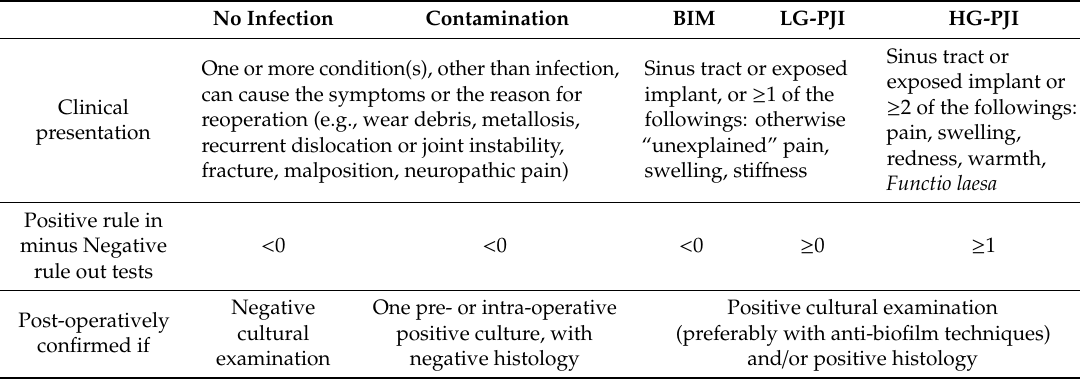
Table 9. Modified WAIOT Definition of peri-prosthetic joint infection (PJI). The presence of a sinus or an exposed implant is considered as a pathognomonic sign of infection.